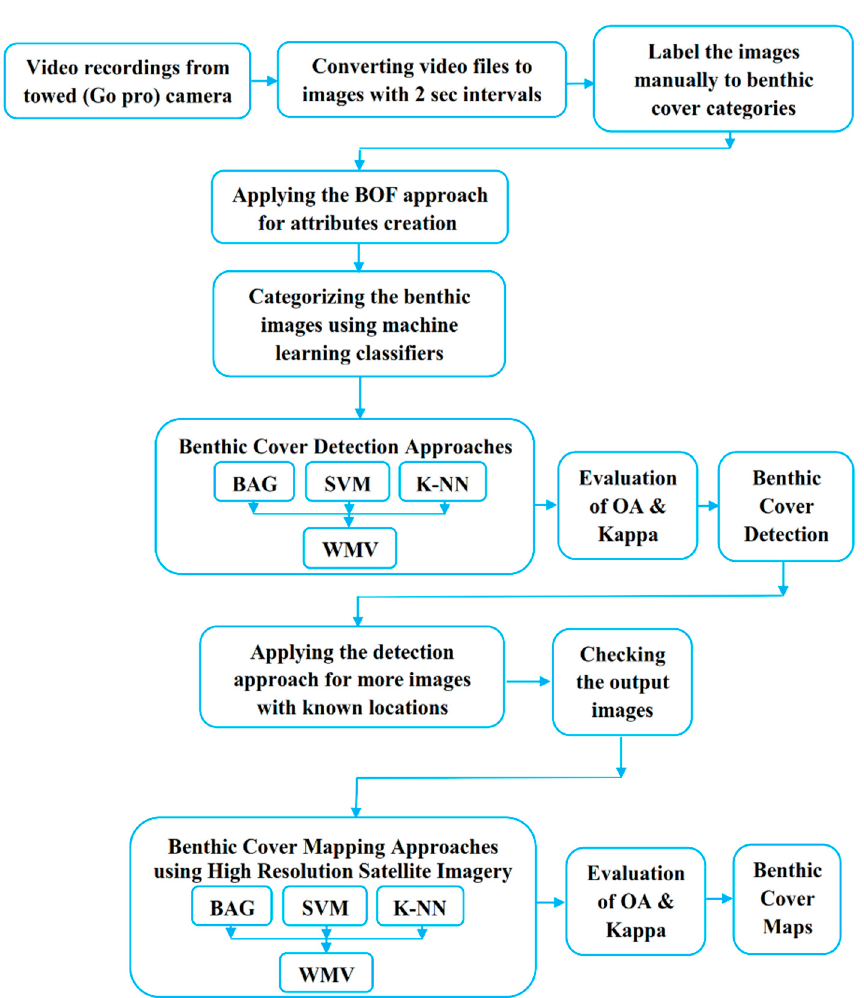
Figure 4. Workflow processing steps of presented methodology for benthic cover detection and mapping by different approaches.